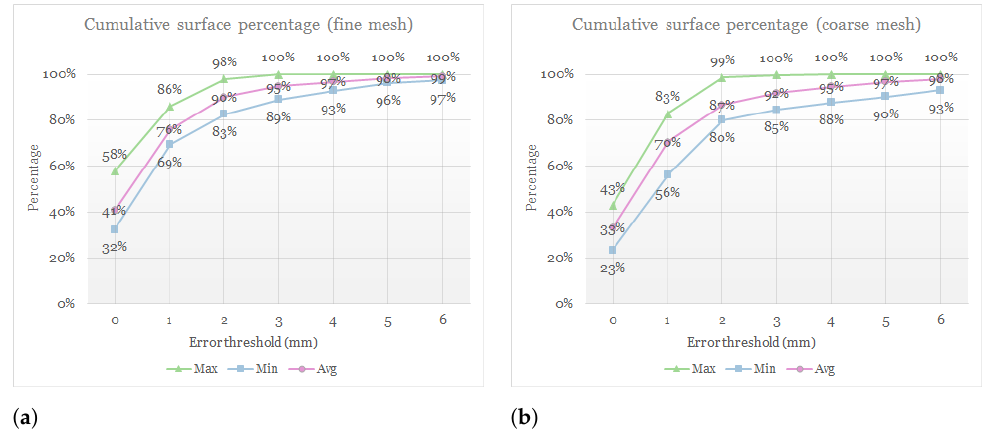
Figure 11. Plots of cumulative surface percentage with error below a predefined threshold. The plots show maximum, minimum, and average surface percentage across the 10 test patients. They also compare the results using a fine mesh ( a ) or a coarse mesh ( b